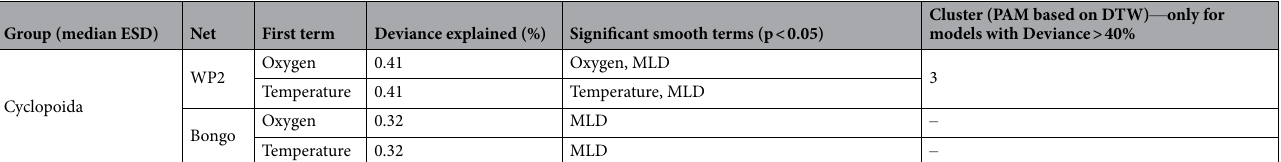
Table 1. Summary of the explanatory power (i.e. % of deviance explained) of the Generalized Additive Models (GAMs) fit to model the global gradients log-transformed Equivalent Spherical Diameter (ESD, µm) as a function of the ten environmental covariates selected, measured for the zooplankton groups and for the plankton nets that sampled enough stations (> 30) and enough individuals (> 20) per group. The significant covariates (p < 0.05) were ranked based on their relative F statistic and are shown. The GAMs displaying a % of deviance explained > 40% were clustered into four groups based on the shape of the smoothing curves of each covariate (Fig. S10).